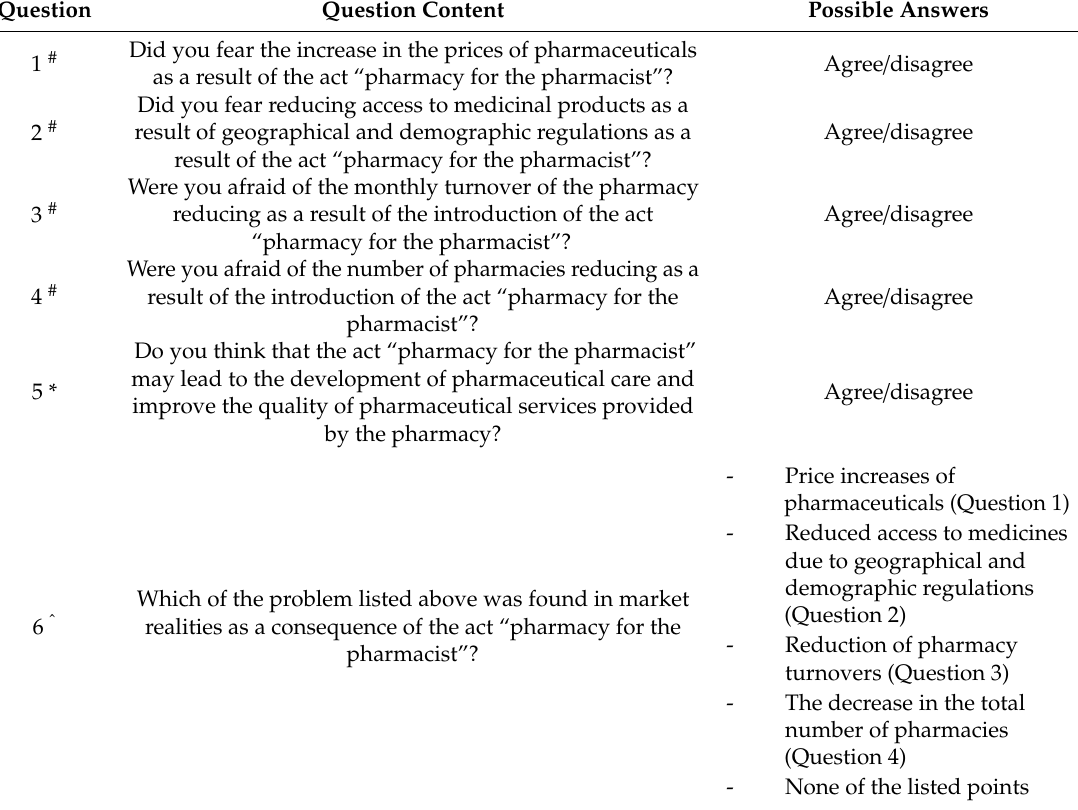
Table 1. Questions used in the